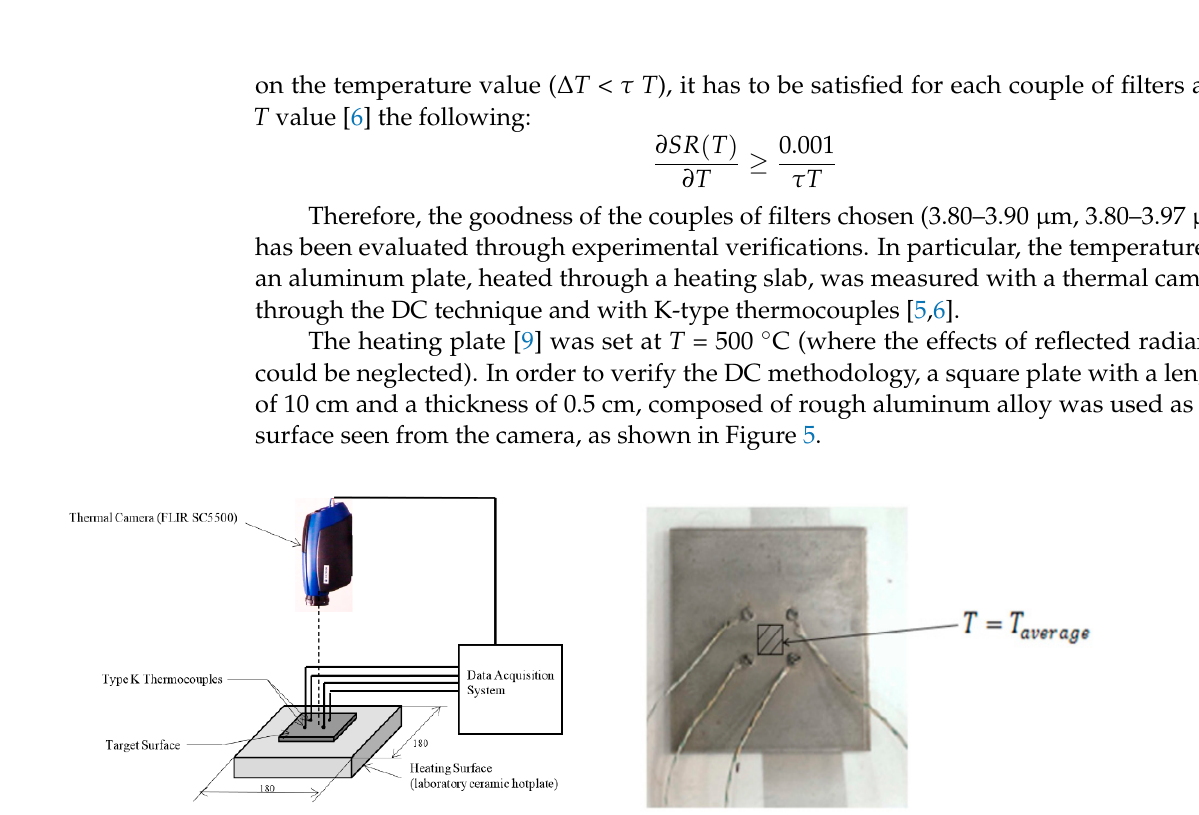
Figure 5. ( Left )—the aluminum plate scheme used for the dual-color (DC) measurement. ( Right )—the aluminum plate heated by the ceramic plate [5,6].